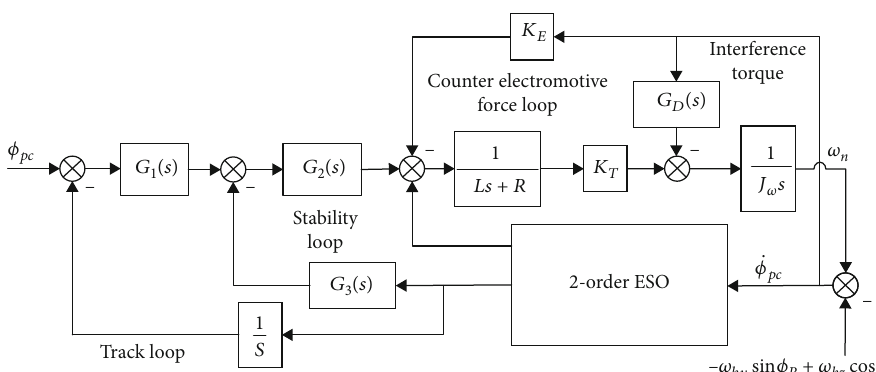
Figure 8: ESO model of the roll frame.